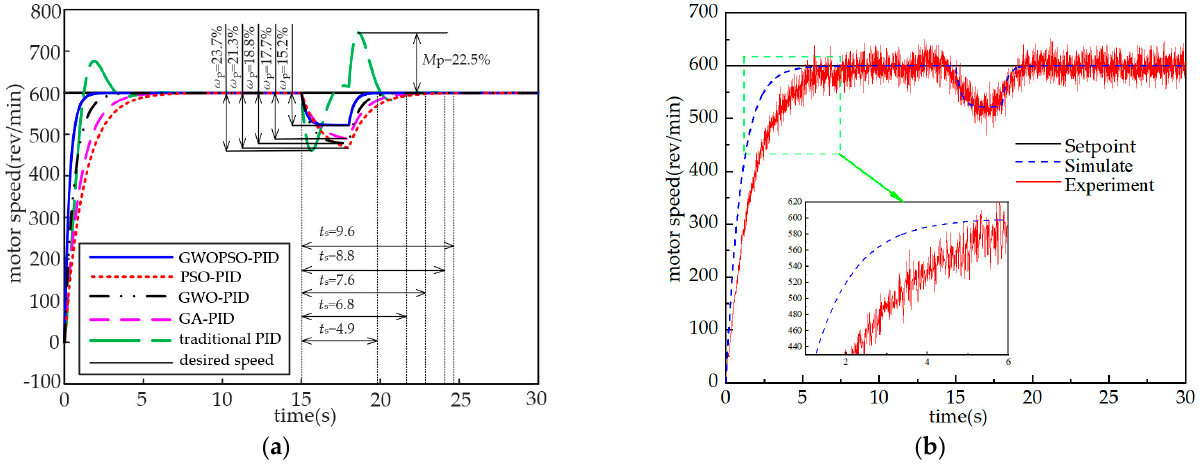
Figure 12. Sudden − varying load response of the PMSS. ( a ) Simulation results; ( b ) experimental results.